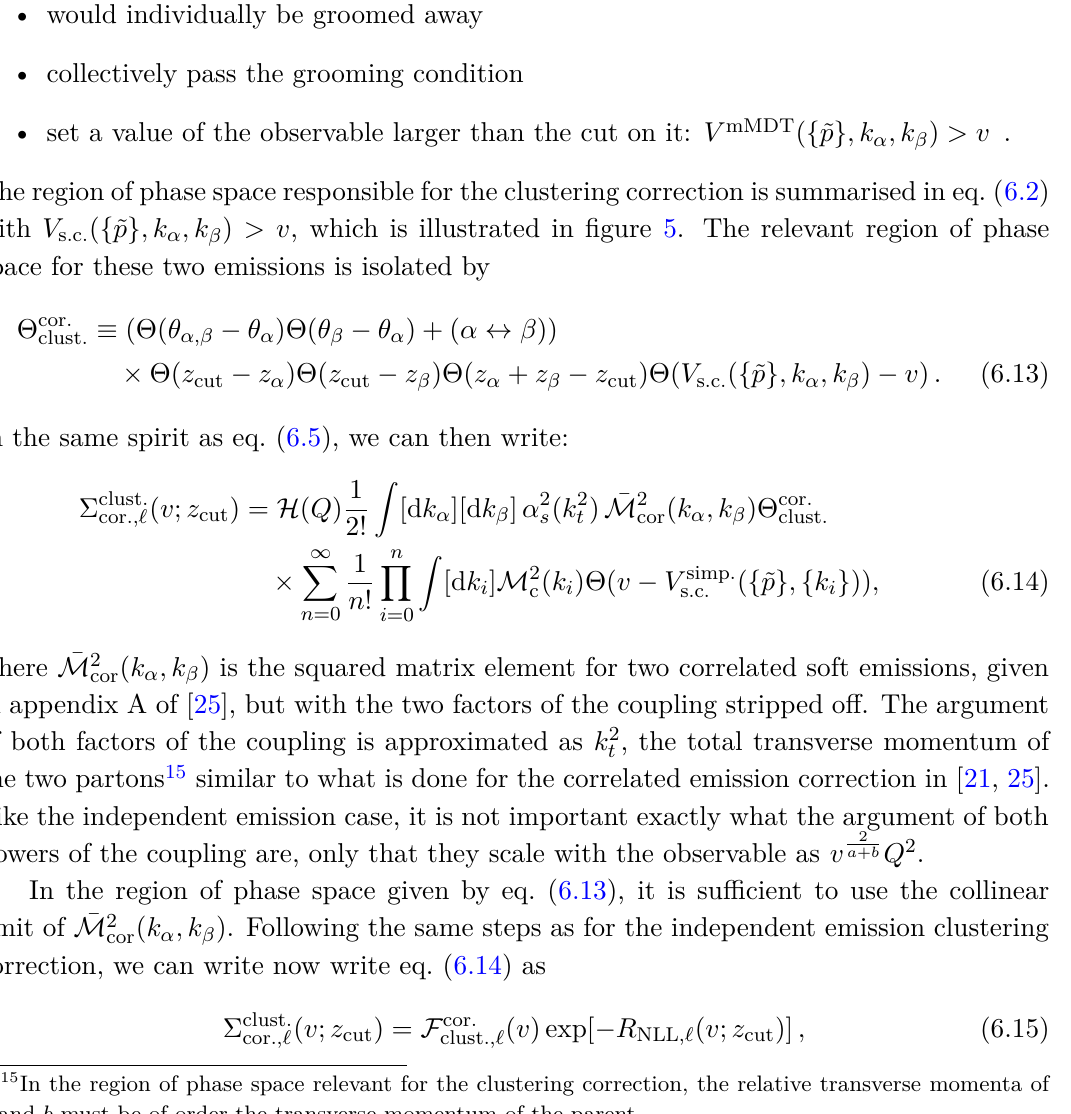
Figure 4. The configuration responsible for the correlated emission clustering correction. Both gluons have z , but have a combined energy fraction greater than z i < z cut are clustered in separate C/A branches, with branch two being de-clustered from the jet first and groomed away. The other gluon is then de-clustered from the quark and is also groomed